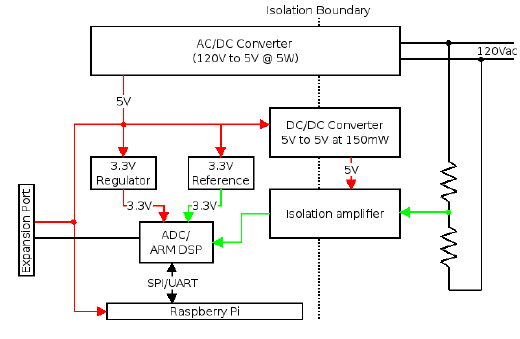
( a ) OPQ Box Block Diagram. The power path is in red, signal path is in green and the digital IO is in black.